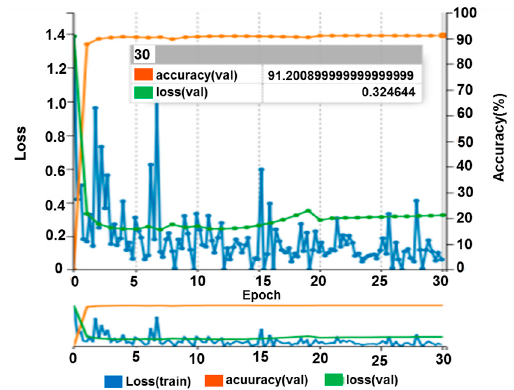
Figure 8. The loss and accuracy curves during training process.